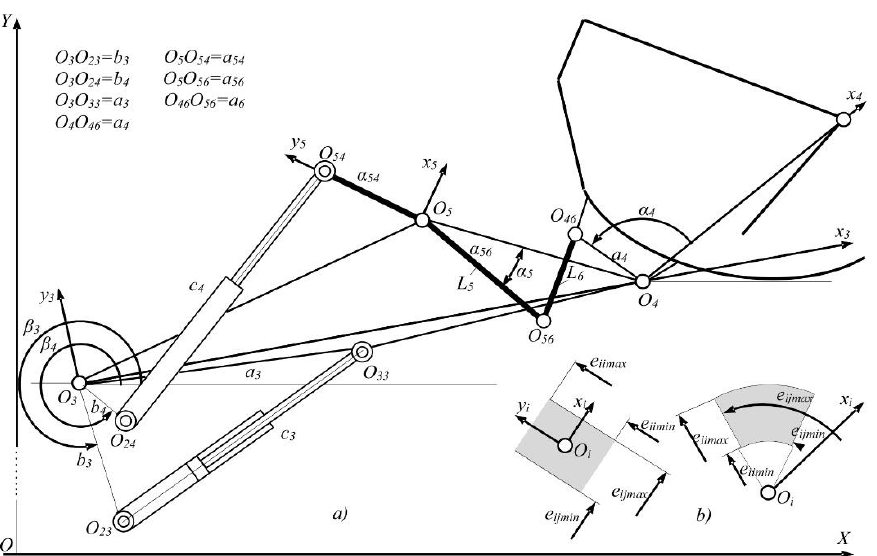
Figure 2. Parameters of Z kinematics manipulator mechanisms: ( a ) coordinates of joints and ( b ) boundaries of search range of joints coordinates. Table 1. Variant solutions for the arm drive mechanism.